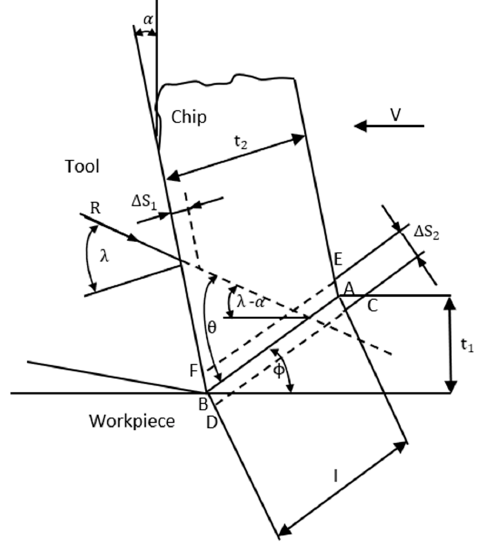
Figure 2. The parallel-sided shear zone model [35].